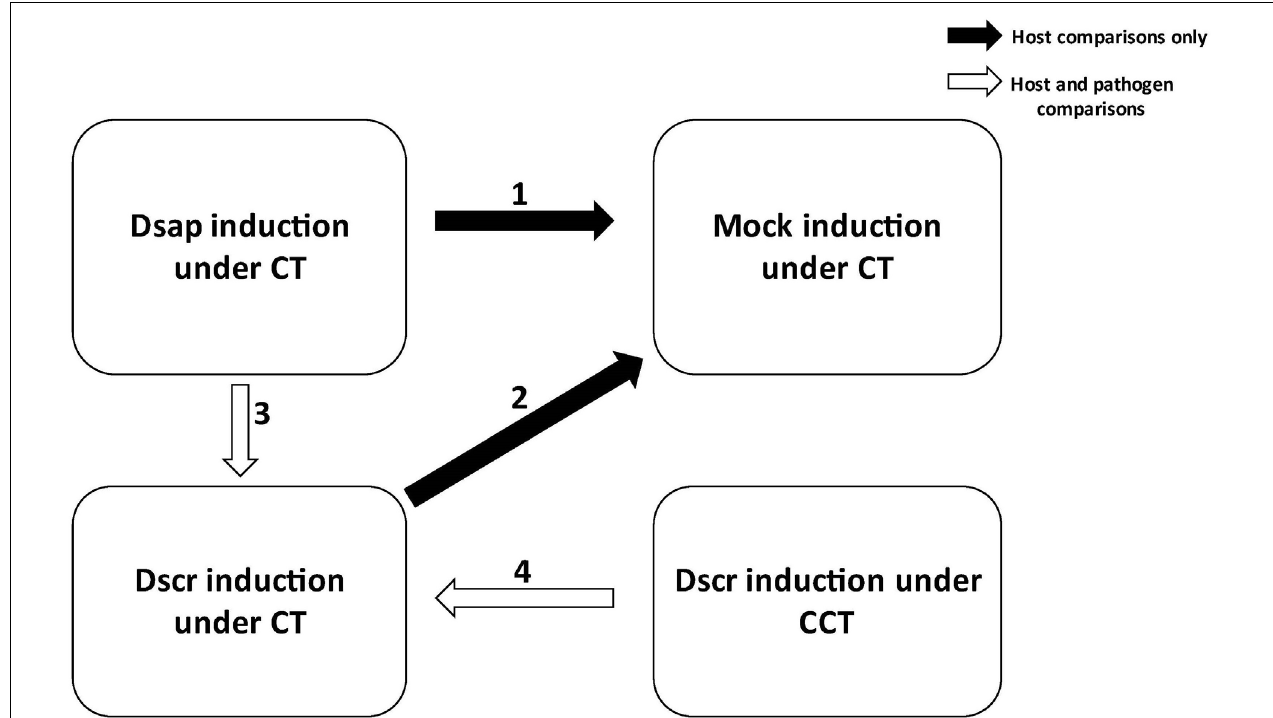
FIGURE 1 | Pairwise comparisons carried out in this study for estimating differential gene expression. Black arrows indicate comparisons for host only; white arrows indicate both host and pathogen comparisons. CT, control treatment; CCT, climate change treatment; Dsap, inoculated with Diplodia sapinea ; Dscr, inoculated with D. scrobiculata ; Mock, inoculated with PDA only.